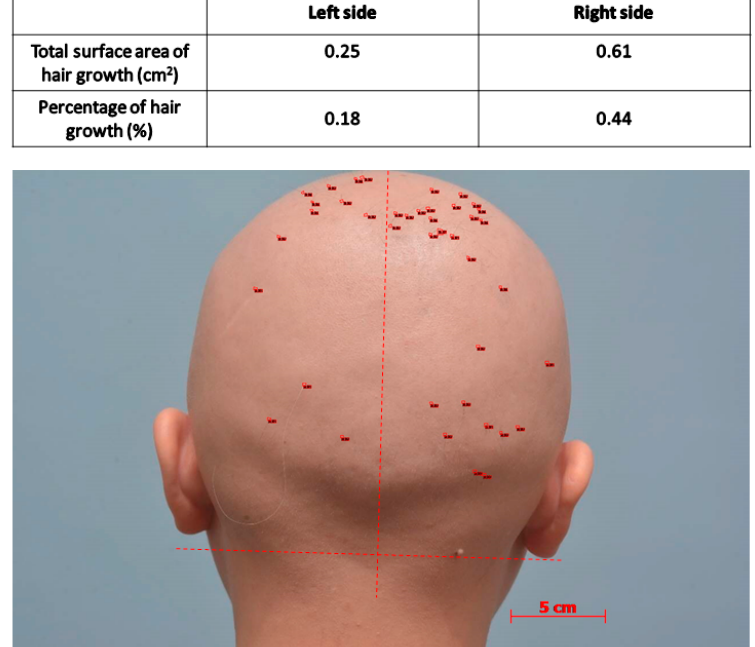
Figure 3. Total surface area and the percentage of hair growth on each side of the scalp before laser treatment. (Percentage of hair growth % = total surface area of hair growth on one side of the scalp/total surface area of the same side of